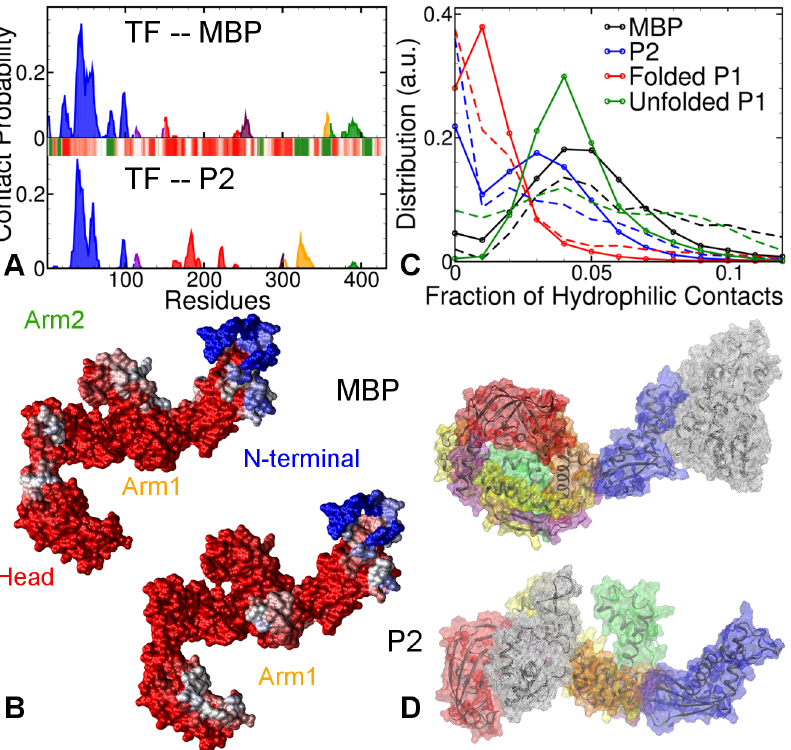
Fig 5. Four 200 ns long AA-MD simulations of extended TF each with full MBP and P2. A. Contact probabilities of TF residues with MBP (top panel) and P2 (bottom panel). The barcode plots the standard hydrophobicity map of TF: color-scaled from red (hydrophilic) to green (hydrophobic). B. Distribution of the fraction of hydrophilic contacts in TF-substrate binding for different substrates. The dashed lines plot the distribution in the first 10 ns, while solid lines with circles plot the distribution over the whole trajectory. C. Visualization of the most important interaction sites (blue) on TF for MBP and P2. D. Representative final conformations of TF-MBP and TF-P2 complexes. The substrates are shown in transparent white colored